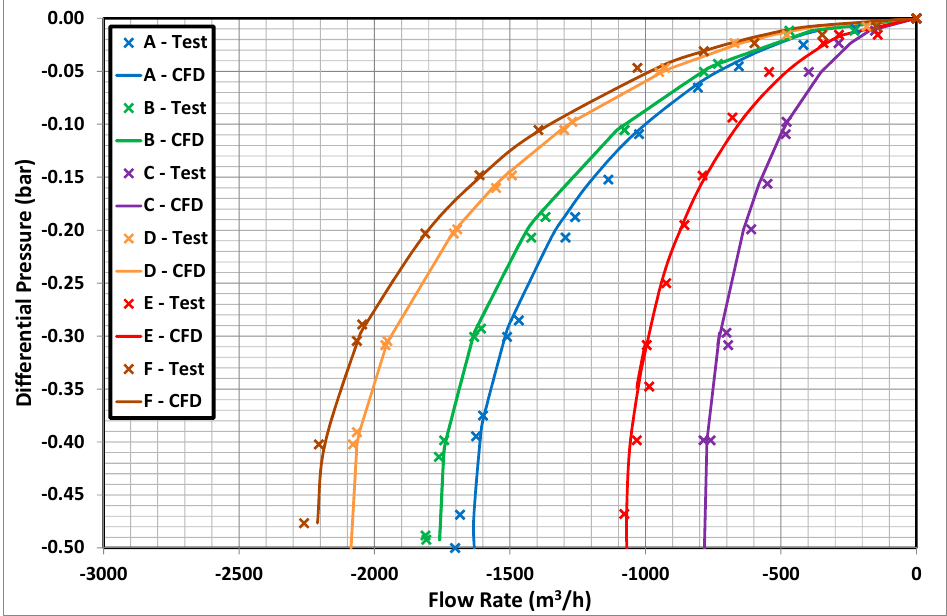
Figure 11. Comparison between laboratory tests and CFD simulations of six different models of air valve. Air intake flow.